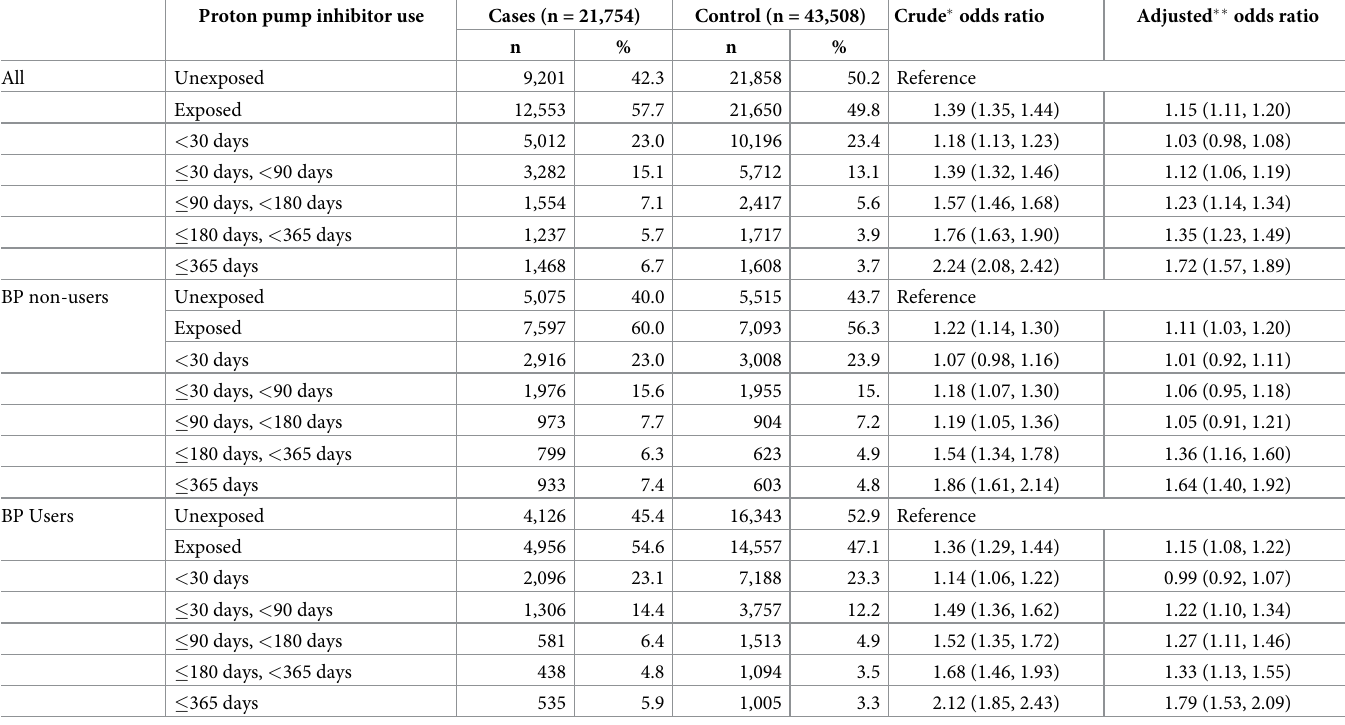
Table 2. Osteoporotic fracture risk related to proton pump inhibitor use according to the duration of exposure stratified by the use of